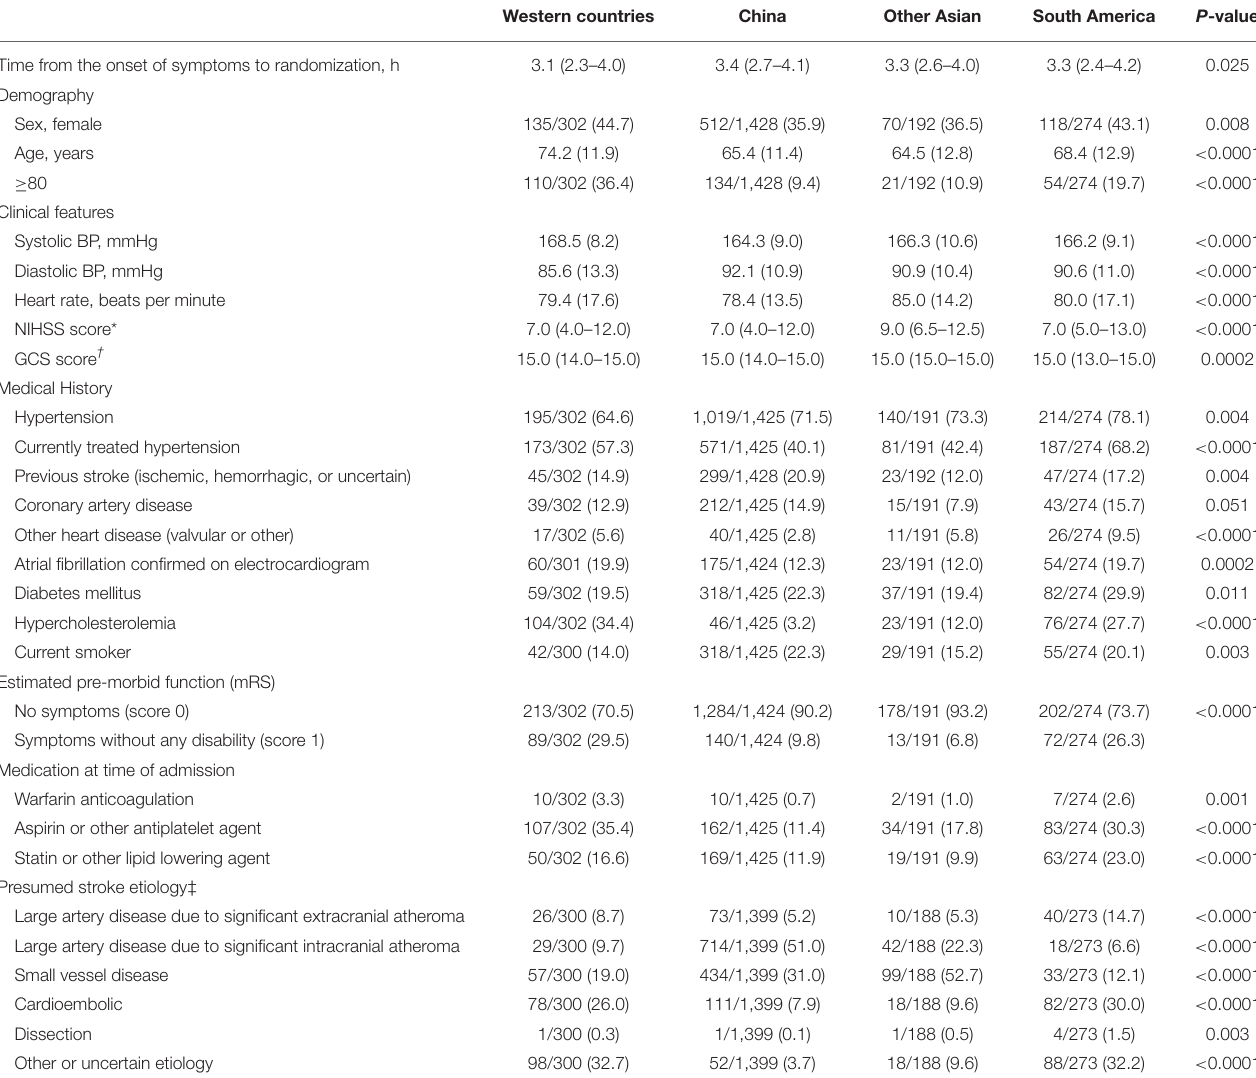
TABLE 1 | Baseline